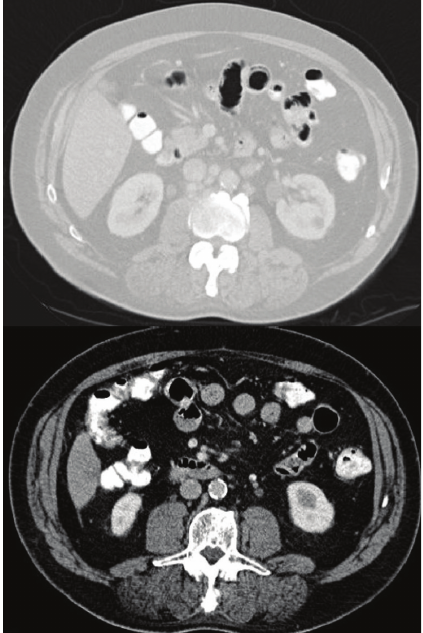
Figure 2: Above: CT scan June 2010 revealing abdominal para- aortic lymphadenopathy. Below: unremarkable CT scan, November